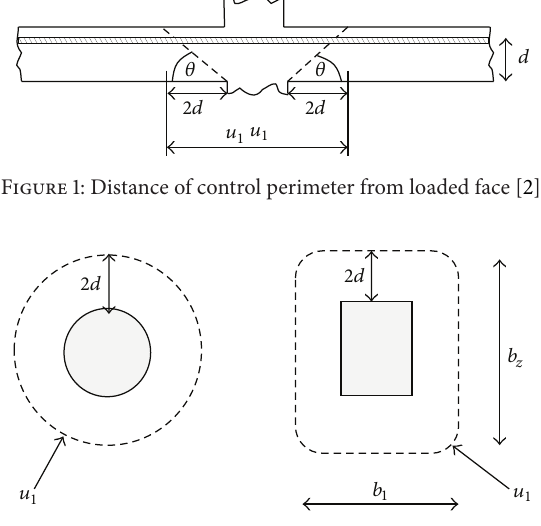
Figure 2: Critical control perimeter for columns with different cross sections [1]. Table 1: Mix proportions.